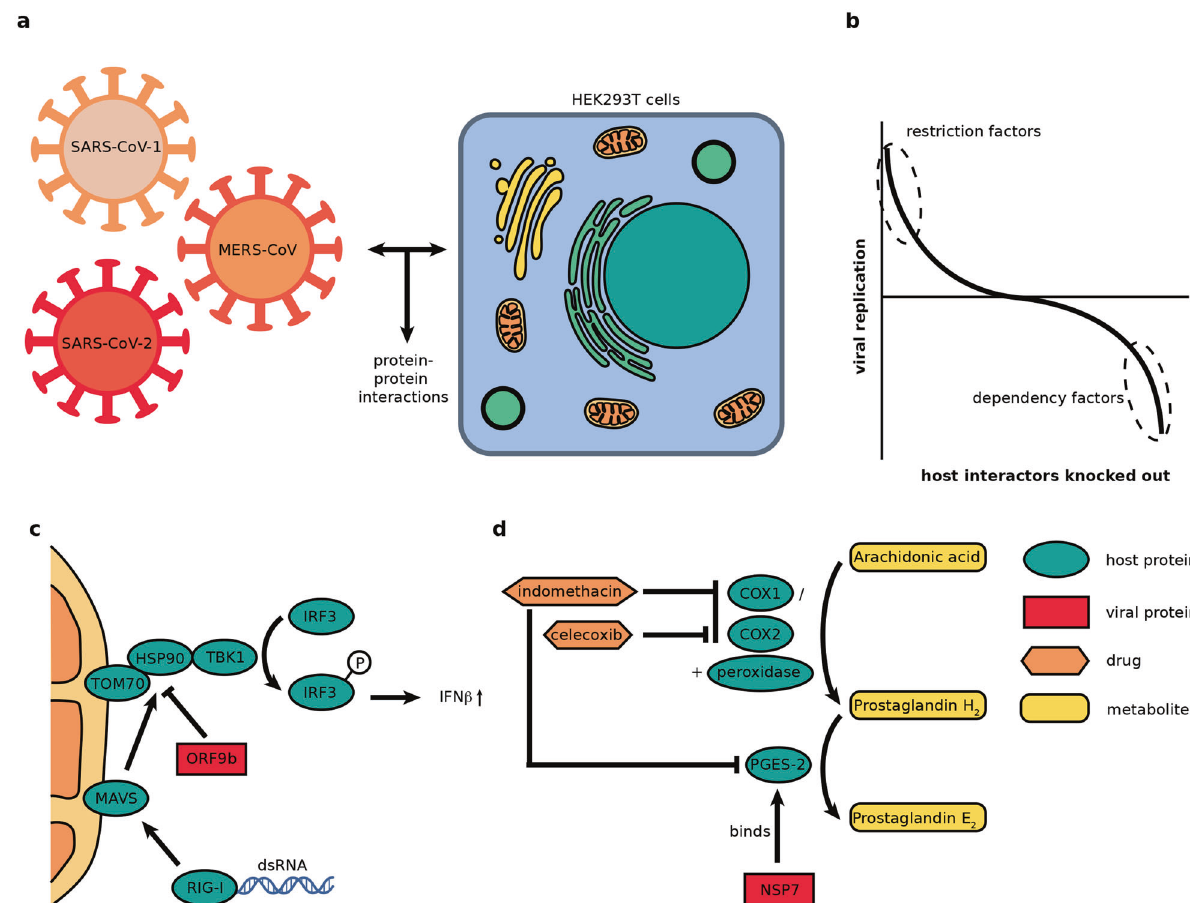
Fig. 1 a , b Interaction candidate selection approach used by Gordon et al. to identify druggable host factors involved in SARS-CoV-2 infection. The authors fi rst screened for interactors with viral proteins of SARS-CoV-1, SARS-CoV-2, and MERS-CoV ( a ) and then fi ltered these through a knockout/-down screen revealing restriction and dependency factors, respectively ( b ). c Proposed mechanism of action for an ORF9b- mediated disruption of viral dsRNA sensing and IFN β production. d Mechanism of action of indomethacin and the control drug celecoxib in prostaglandin